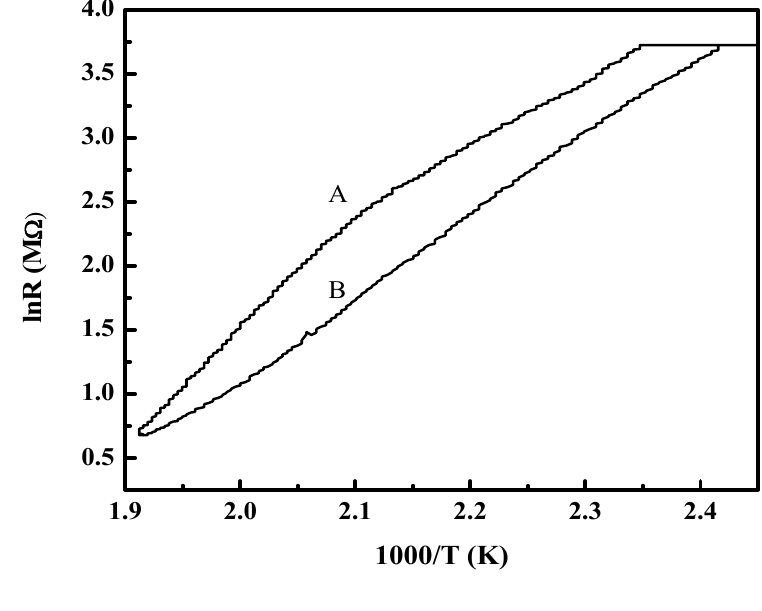
Figure 10. Temperature dependence of the resistance of ZnO-based sensor film.